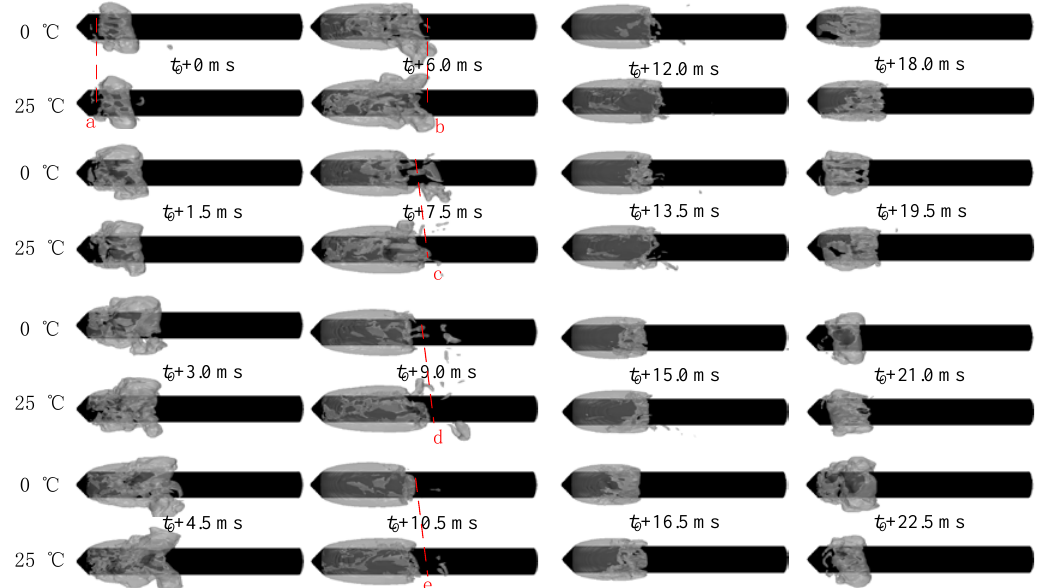
Figure 7. Comparison of natural cavity evolution between 0 ◦ C and 25 ◦ C cases. To analyze the evolution of cavitation bubbles, Figure 8 shows the changes in cavity volume at the two temperatures. The volume of the cavity changes periodically and oscil- lates within a certain interval. As the cavity collapses and sheds, the volume of the cavity reaches its minimum value, from which point it begins to grow to its maximum volume once again. Interestingly, the volume change of cavitation bubbles at 25 °C is smoother than at 0 °C, and the volume change in each cycle is also larger. In some periods, the max- imum volume of the 0 °C case exceeds the void volume of the 25 °C case. The average volume of the cavity at 0 °C is 1.41 × 10 − 4 m 3 , compared with 1.43 × 10 − 4 m 3 at 25 °C. The average hole volume at 25 °C is slightly larger than that at 0 °C and there are a greater number of holes. This shows that the lower temperature makes the cavity smaller and accelerates the collapse and shedding processes. Figure 8. Comparison of the natural cavity volume change between 0 °C and 25 °C cases. Figure 9a shows the pressure change at two positions at the two temperatures. The pressure change is also periodic. When the cavity reaches position P1, the mini- mum pressure at each temperature is the saturated vapor pressure. With the collapse and shedding of the cavity bubbles, the pressure fluctuates violently. When the shedding cavity moves to position P3, pressure pulsations can be detected, and the pulsation period is the same as the cavity collapse and shedding period. At the two points, the average pulsation pressure in the 0 ◦ C case is higher than in the 25 ◦ C case, indicating that the pressure pulsations caused by cavitation are more obvious at lower temperatures. This is because the saturated vapor pressure at 0 ◦ C is 611 Pa and that at 25 ◦ C is 3169 Pa. At the same flow rate, the 25 ◦ C cavity is more stable, shedding and collapsing more smoothly, than in the 0 ◦ C case, demonstrating the effect of the pressure pulsations on the shedding and collapse processes. Figure 10 shows the power spectral density (PSD) frequency distribu- tion diagram at pressure detection points P1 and P3 (sampling frequency is 0–2.5 × 10 4 .). The main frequency of natural shedding at 0 ◦ C is 50.0 Hz, compared with 45.8 Hz at 25 ◦ C. It proves that low temperature increases the shedding frequency, that is, the cycle of cavitation evolution is shortened, and the cavitation evolution is intensified, which also corresponds to the result in Figure